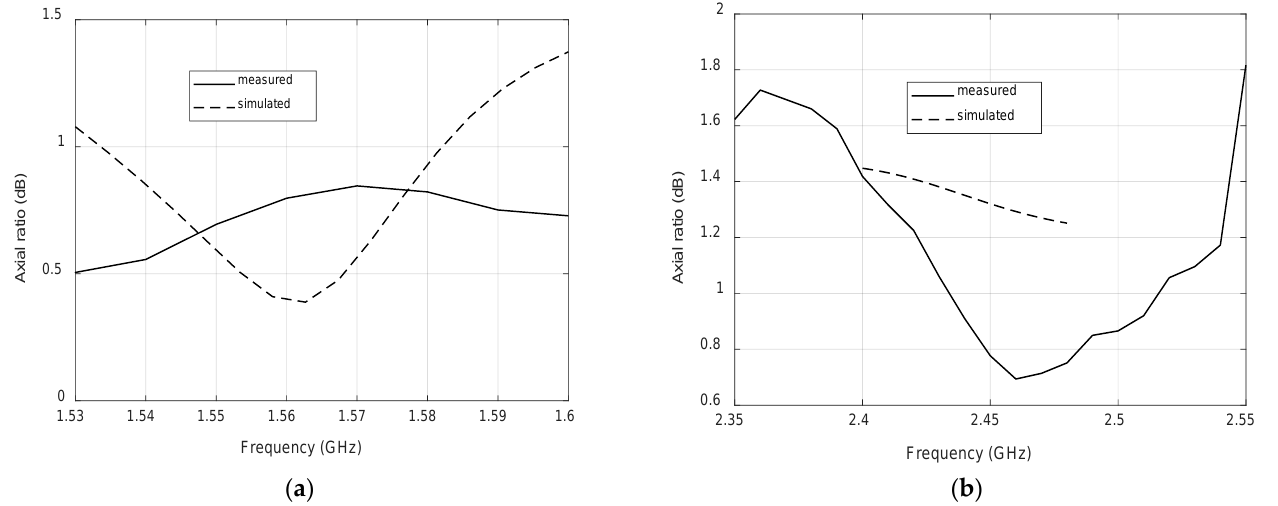
Figure 10. Simulated and measured axial ratio: ( a ) GPS band; ( b ) LoRa band. Finally, the measured radiation patterns of the antenna for both ports are presented in Figure 11, for the cutting plane Phi = 0° and normalized to zero. The antenna has been measured in the anechoic chamber by using the same reference antenna employed for the axial ratio measurements. The measured − 3 dB beamwidths are 75° for the LoRa band, and 93° for the GPS band, showing again a good agreement with simulation results.